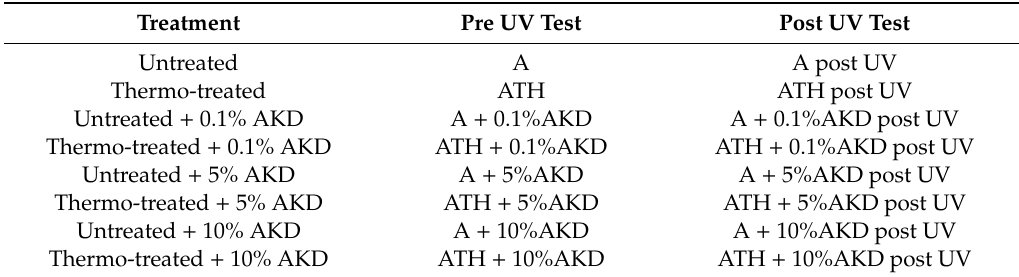
Table 1. Experimental design of untreated and thermo-treated alder samples. Treatment Pre UV Test Post UV